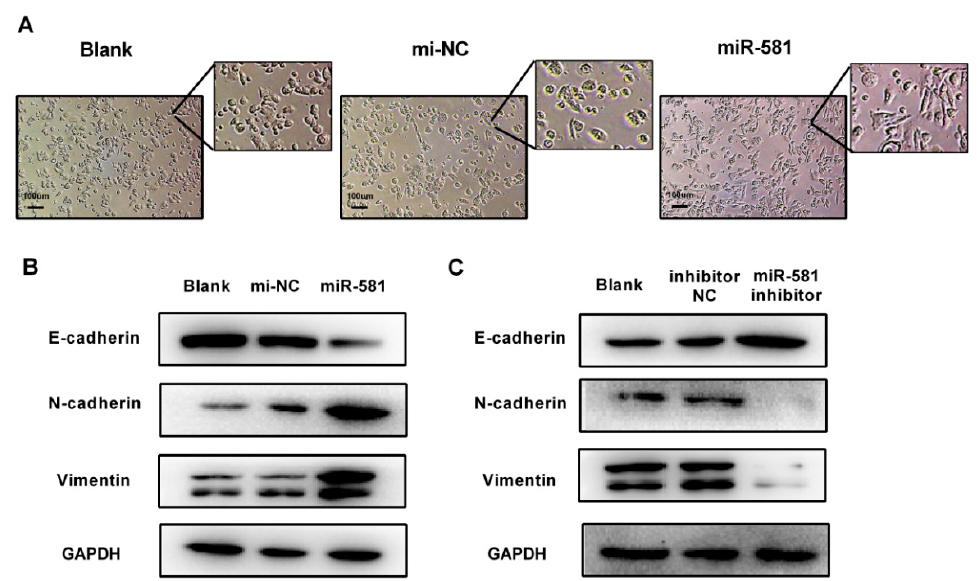
Figure 6. MiR-581 modulates the epithelial to mesenchymal transition (EMT) process in SW480 cells. ( A ) Cell morphological changes in epithelial SW480 cells after transfection of miR-581 mimics and negative control. ( B ) EMT markers E-cadherin, N-cadherin, and Vimentin were detected in miR-581-overexpressing cells. ( C ) EMT markers E-cadherin, N-cadherin, and Vimentin were detected in miR-581 knockdown cells.